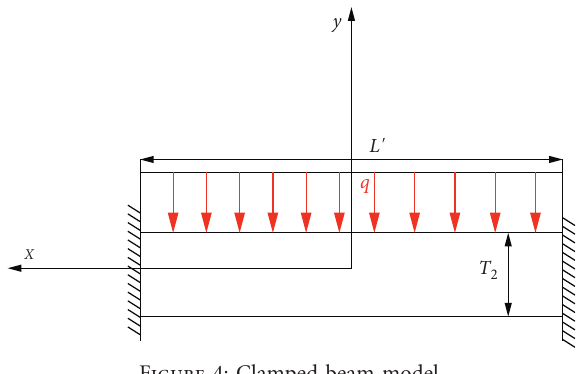
Figure 4: Clamped beam